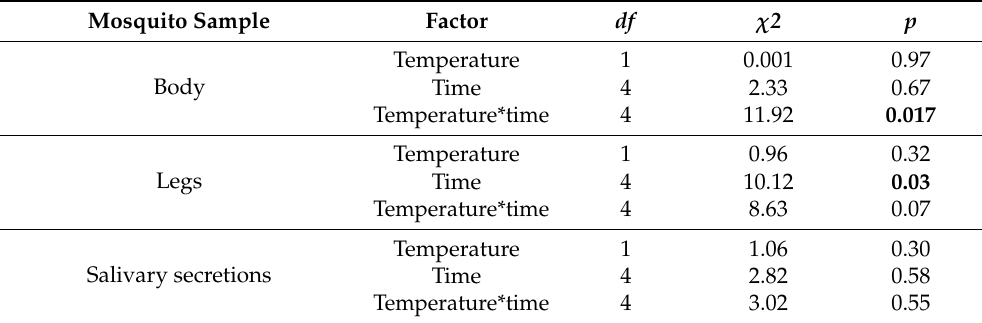
Salivary secretions